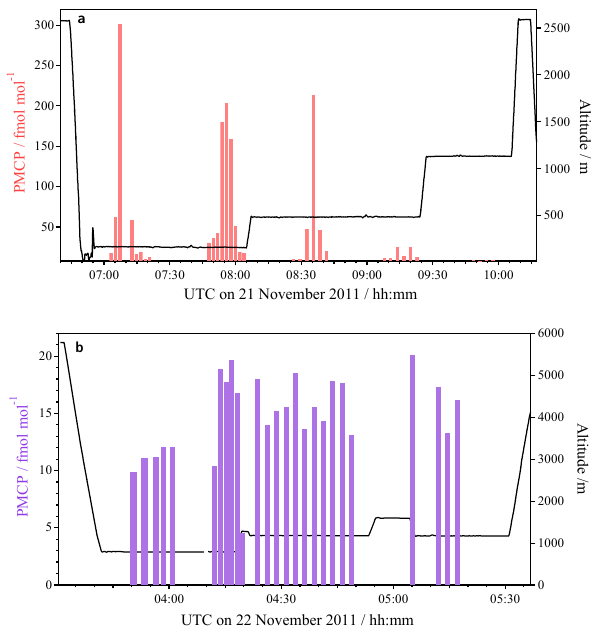
Figure 6. Time series of PMCP concentrations on 21 November ( a ) and 22 November 2011 ( b ). Each bar represents the averaged value during each sampling interval.